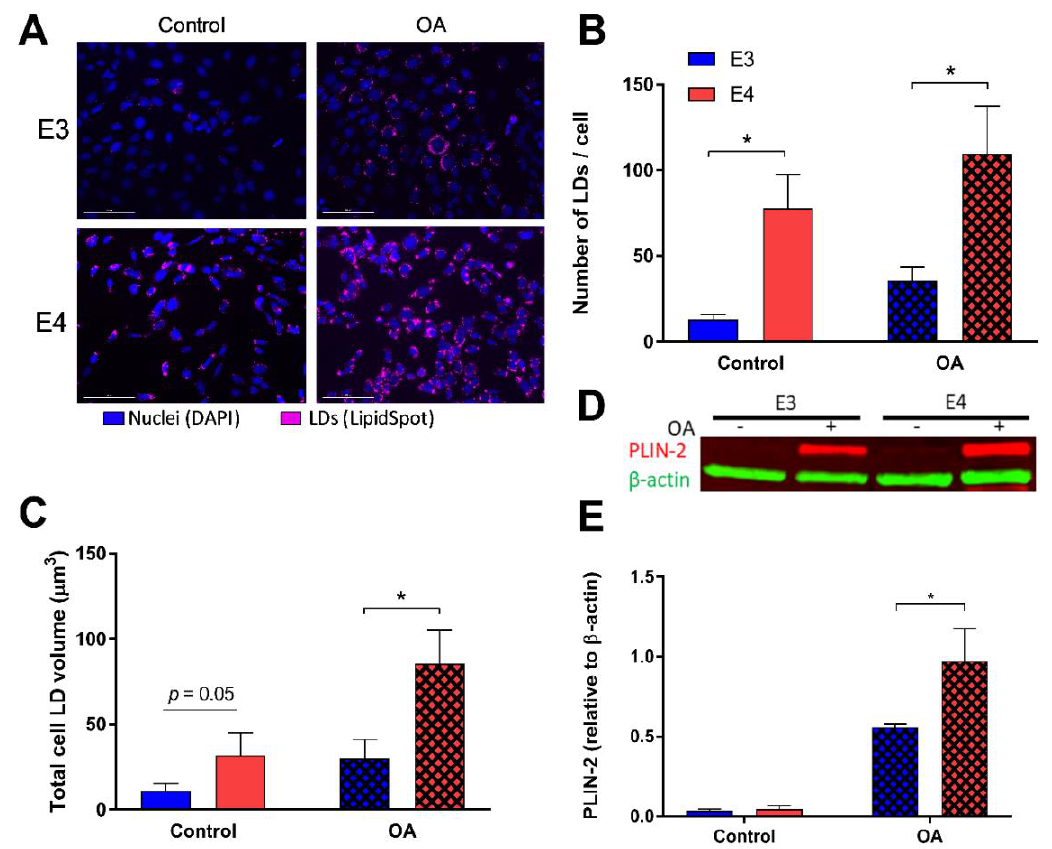
Figure 1. E4 astrocytes have increased lipid droplet (LD) count, LD volume, and LD associated protein. ( A ) Astrocytes expressing either E3 or E4 were stained with LipidSpot to quantify lipid content under control conditions (left), and after 24 h oleic acid (OA) supplementation (“lipid-loaded”; right). The number of LDs per individual cell ( B ) and total LD volume per cell ( C ) were quantified. Values represented are means +/ − SEM ( n = 10). Data were analyzed by t -test for specific comparisons between means; * p < 0.05. ( D ) Representiative image of the total expression of perilipin-2 (PLIN2) and β -actin in control or lipid-loaded E3 and E4 astrocytes was determined by SDS-PAGE and Western blotting and quantified ( E ). Values represent mean +/ − SEM ( n = 3). Data were analyzed by by t-test; * p < 0.05. Scale bar = 100µm.